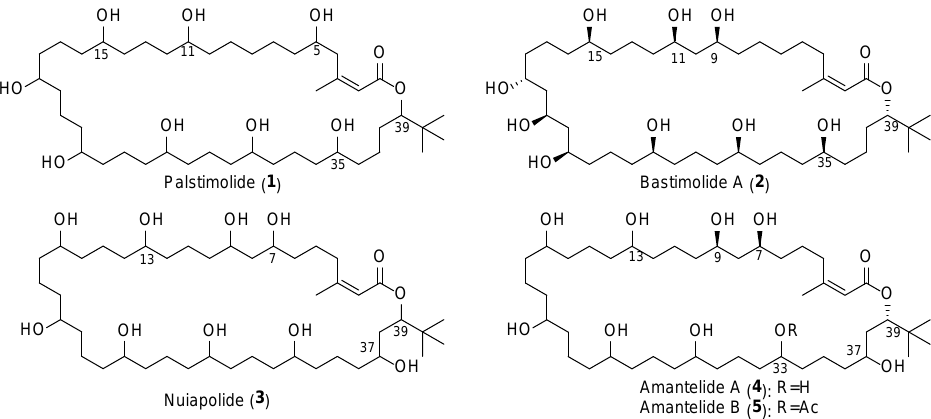
Figure 1. Structure of palstimolide A ( 1 ) together with the related cyanobacterial 40-membered polyhydroxy macrolides bastimolide A [6], amantelides A and B [8], and nuiapolide [9].